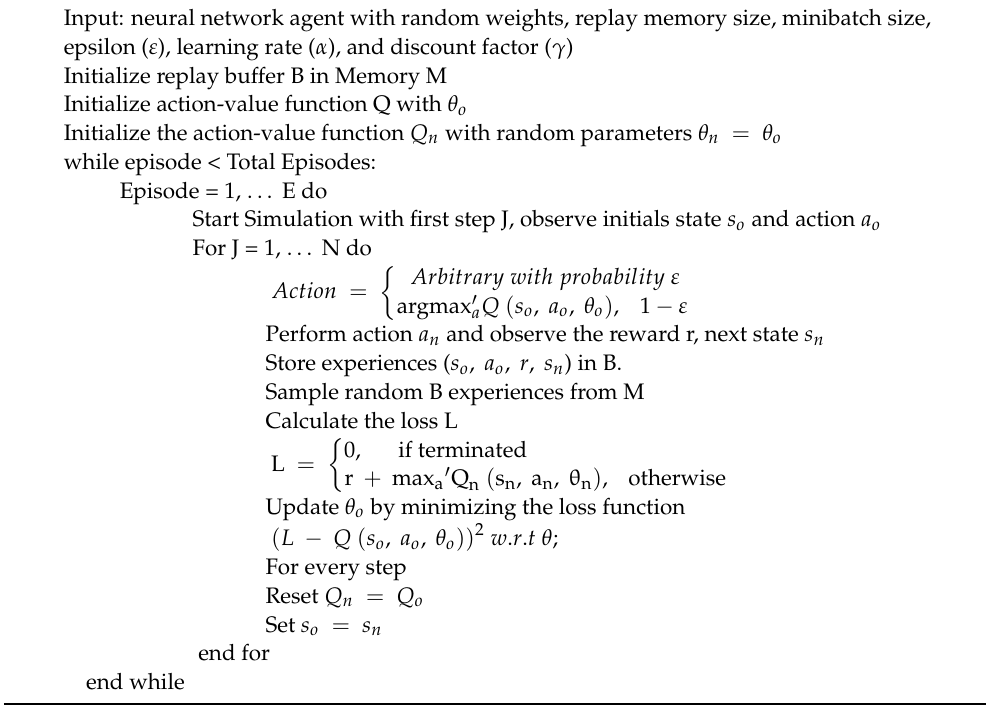
Algorithm 1: Training of deep Q network with Experience Replay on a traffic